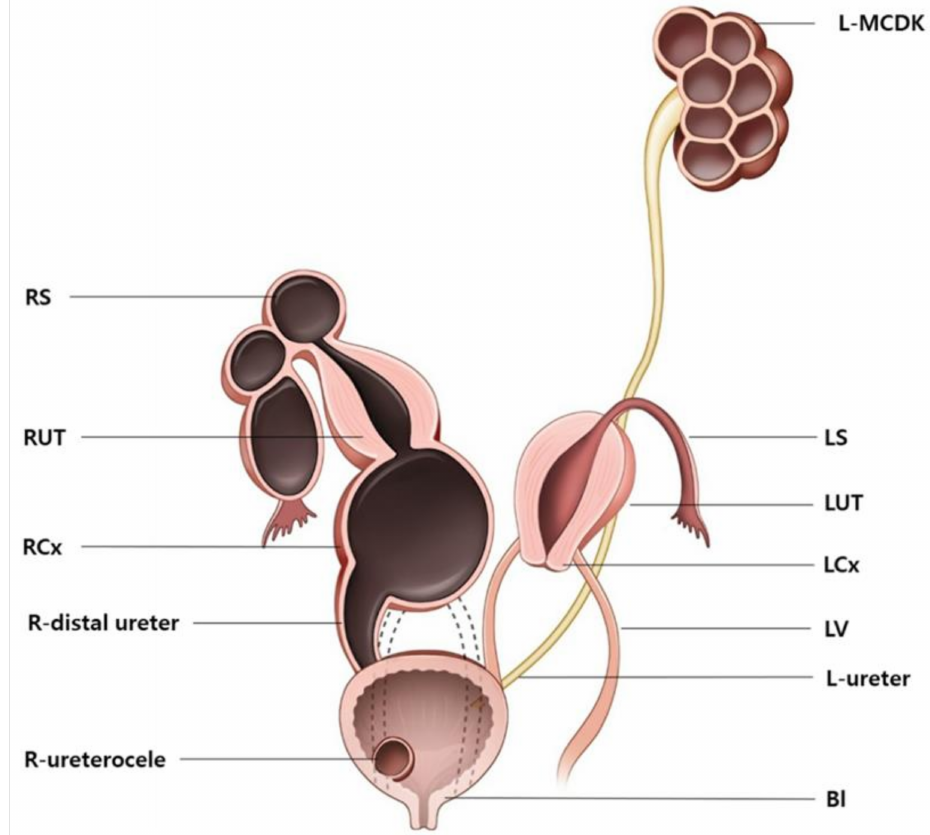
Figure 3. Illustration of this case of a rare category of Herlyne–Wernere–Wunderlich syndrome of a uterine didelphys combined with unilateral cervical dysgenesis, vaginal agenesis, cervico-ureteral fistula, ureterocele, and renal agenesis, combined with a contralateral multicystic dysplastic kidney. RS, right salpinx; RUT, right hemiuterus; RCx, right cervix; R-distal ureter, right distal ureter; R- ureterocele, right ureterocele; L-MCDK, left multicystic dysplastic kidney; LS, left salpinx; LUT, left hemiuterus; LCx, left cervix; LV, left vagina; L-ureter, left ureter; Bl,